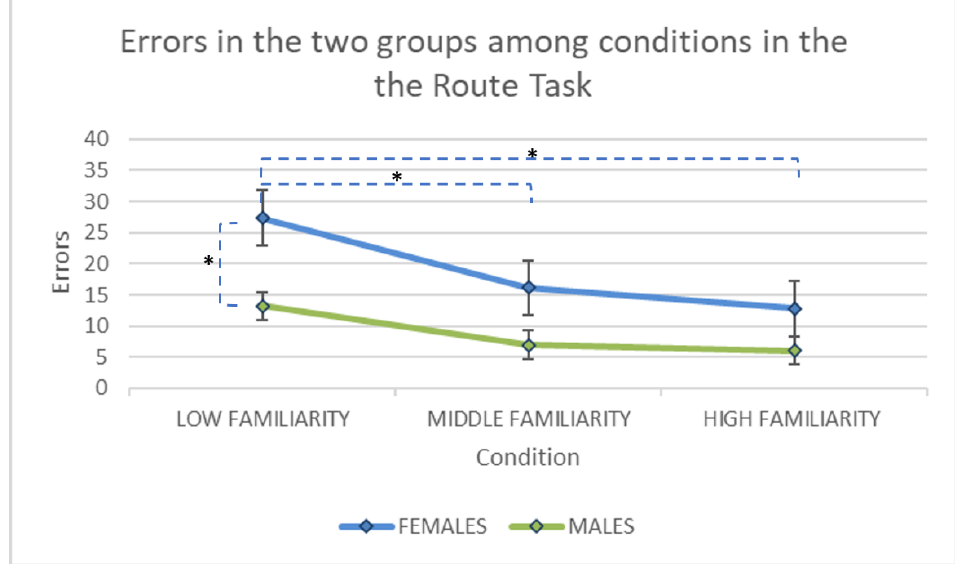
Figure 3. The number of errors made by the two groups (M = male group: blue line; F= female group, green line), among the three conditions (three, five and seven reward boxes) in the Route task. Asterisks indicate the significant differences between groups or conditions within groups.